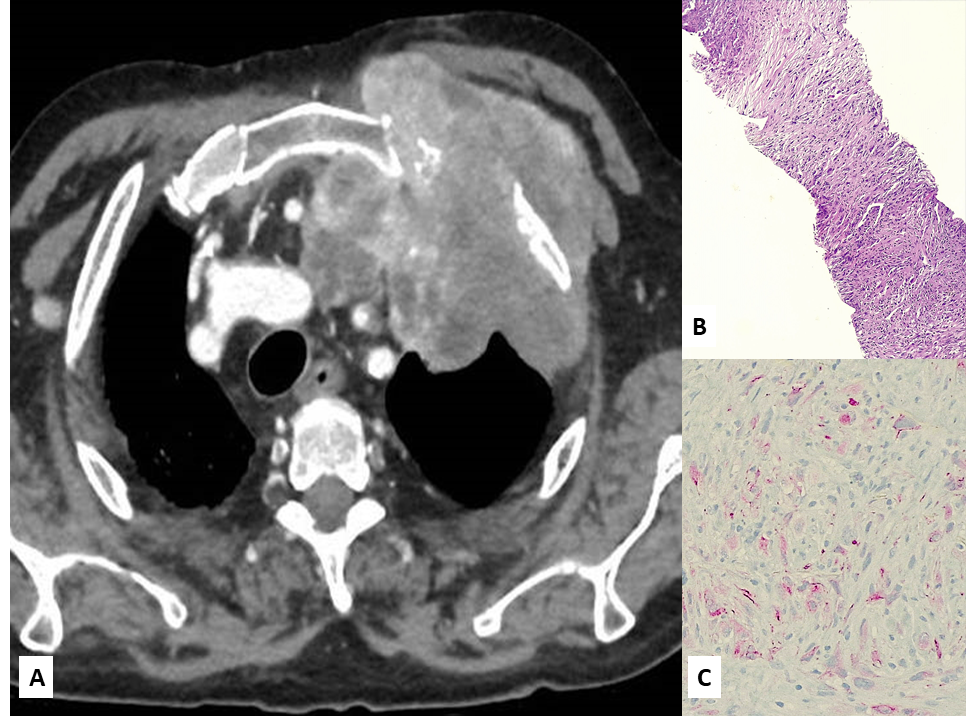
Figure 5. Chest CT scan showing a laterocervical mass arising from the superior sulcus of the left lung ( A ). A surgical biopsy revealed a sarcomatoid mesothelioma ( B ) focally expressing D2-40 ( C ).